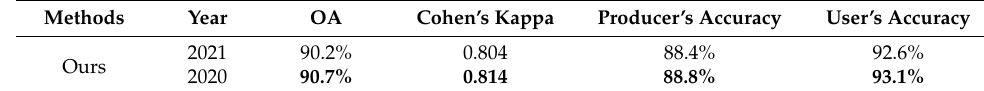
Figure 11. The 2021 Taoyuan County mapping results. ( a ) The 2021 10 m built-up land cover map in Taoyuan. ( b ) Remote sensing imagery of new built-up area in 2021. ( c ) Remote sensing imagery of the same area in 2020. ( d ) Results of mapping of new built-up area in 2021. ( e ) Results of mapping of the same area in 2020. Table 5. Results of Taoyuan County of 2021.